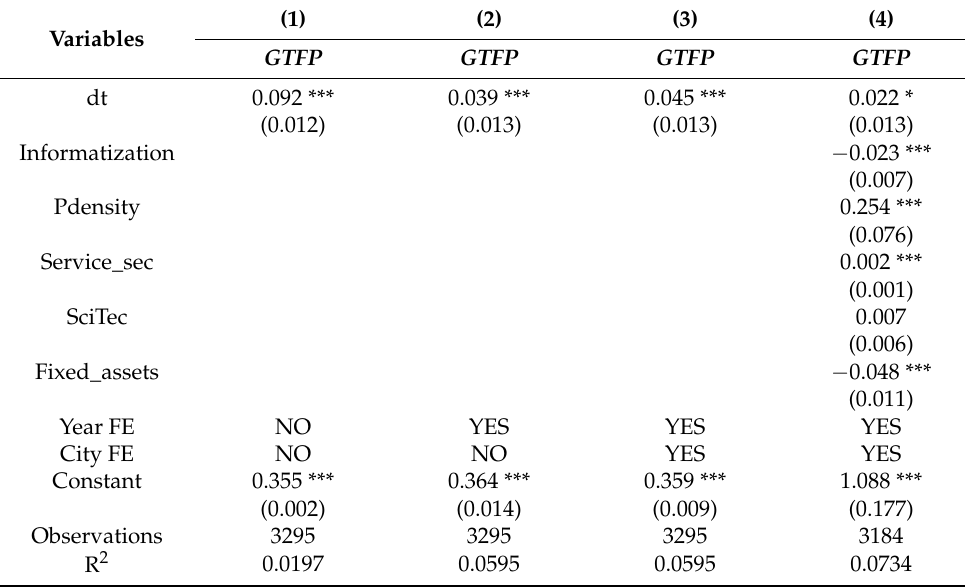
Table 6. PSM-DID estimation